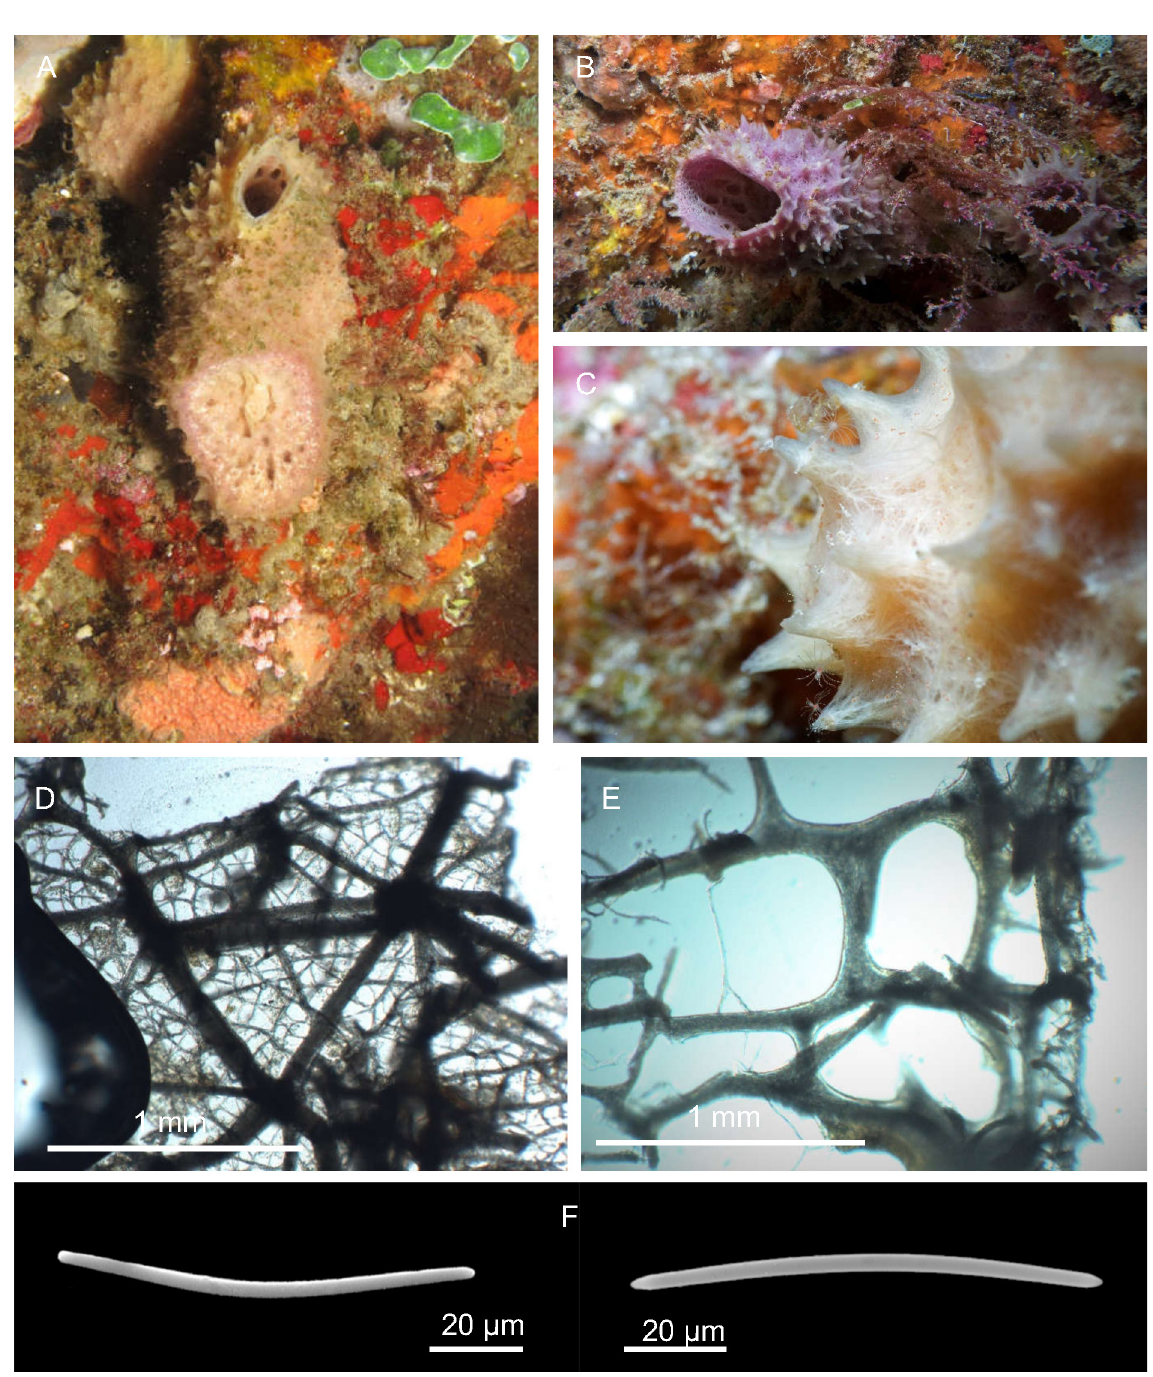
Fig. 6. Callyspongia ( Cladochalina ) aerizusa Desqueyroux-Faundez, 1984. A – C . Specimens in situ , respectively PdO18a, PO82 and PO86. D . Ectosomal skeleton. E . Choanosomal skeleton . F .